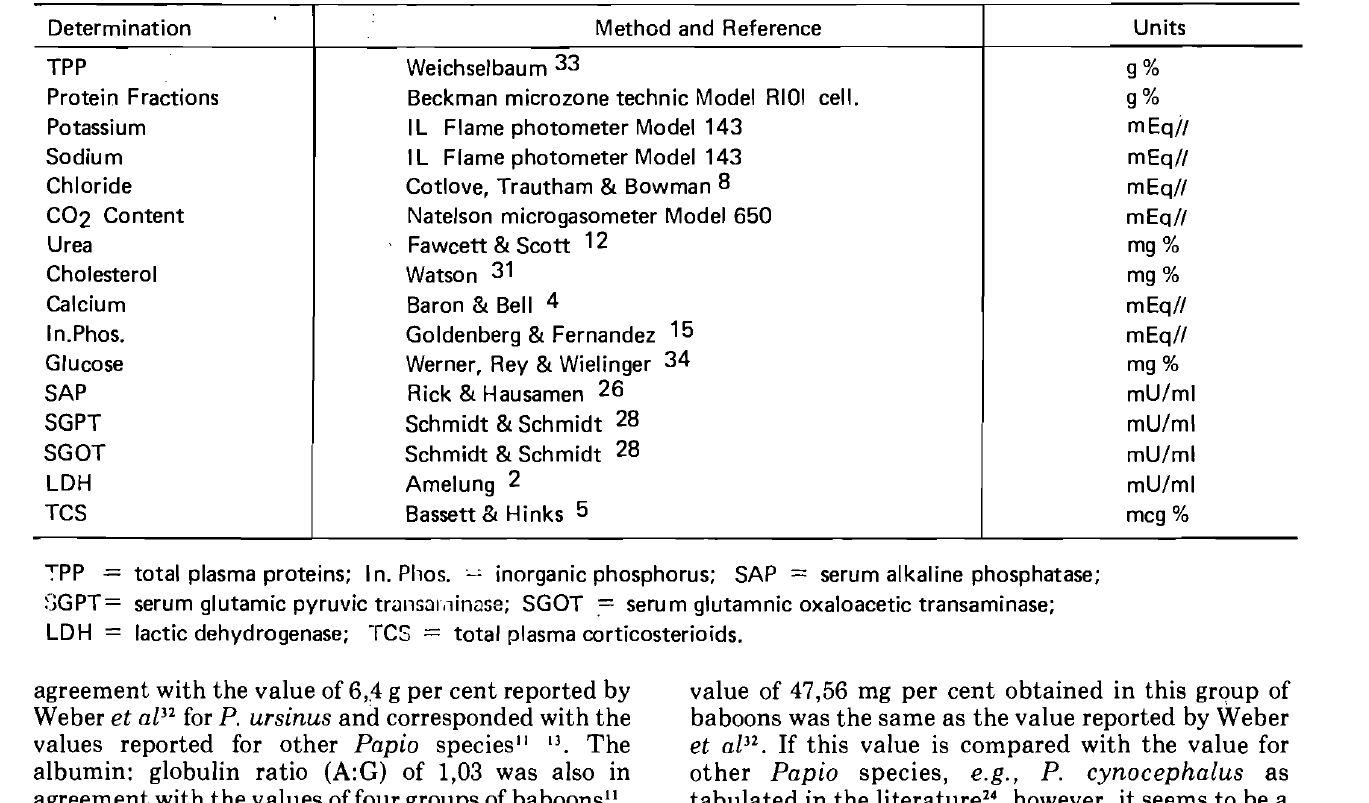
BLOOD CHEMISTRY VALUES FOR THE CHACMA BABOON UNDER STANDARD